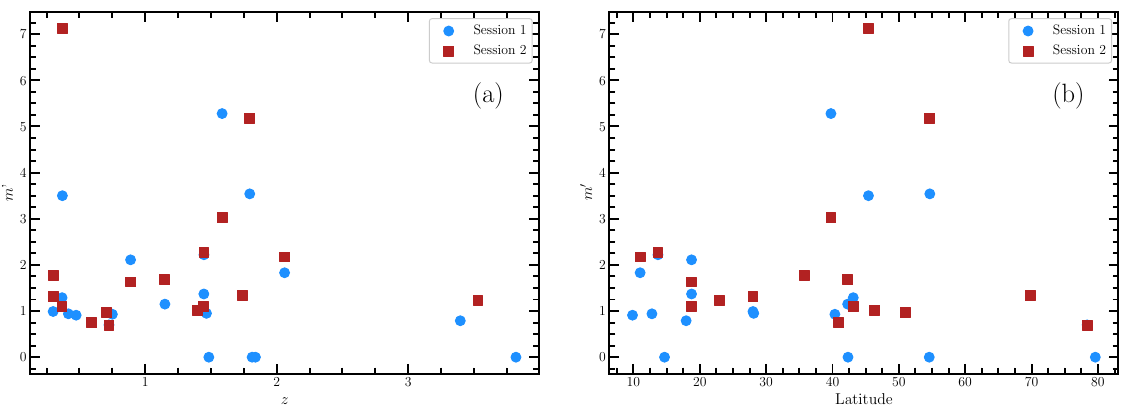
Figure 3. ( a ) The modified modulation index ( m (cid:48) in per cent) versus redshift ( z ) of the target sources observed in session 1 (blue circle) and session 2 (red square); ( b ) the modified modulation index ( m (cid:48) in per cent) versus Galactic latitude of the target sources observed in session 1 (blue circle) and session 2 (red square).